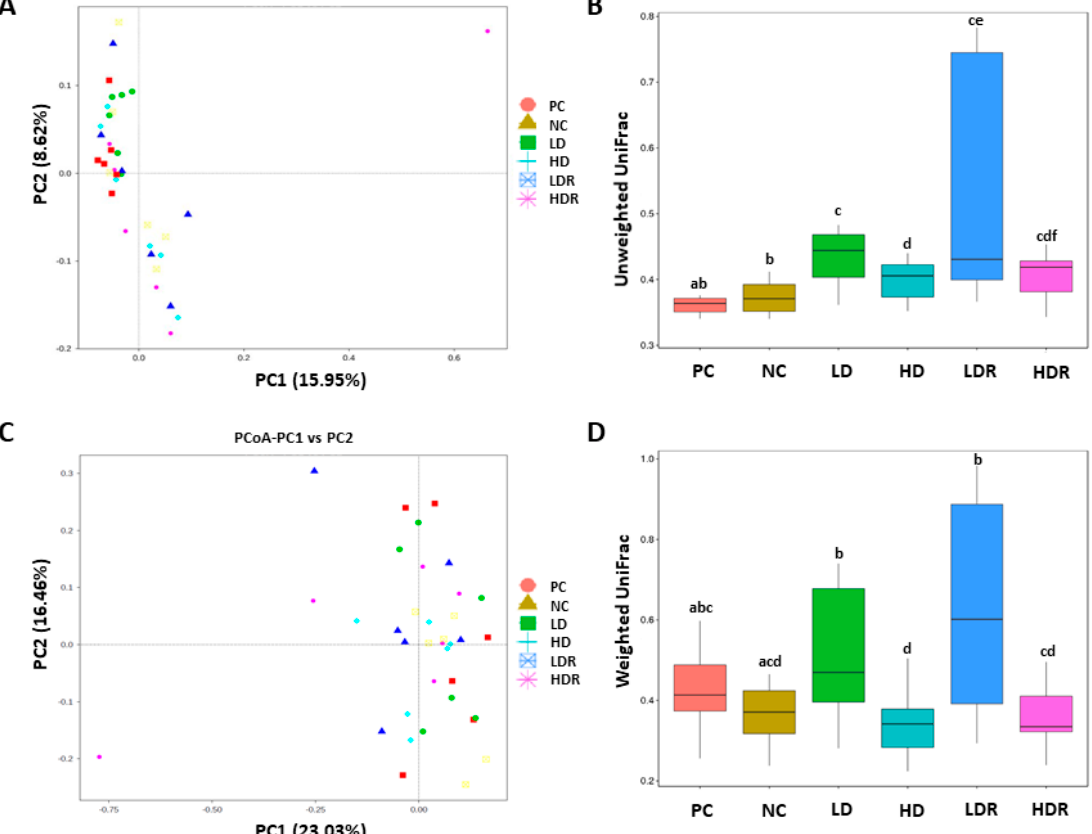
Figure 3. Beta diversity of the fecal bacterial community in pigs fed with low-protein diets supplemented with a corn-expressed phytase. ( A ) Principal Coordinates Analysis (PCoA) of unweighted UniFrac distances showing the diversity of fecal microbiota across individual animals assigned to 6 dietary groups. Each node represents an individual pig, ( B ) Unweighted UniFrac distances shown for each dietary group, ( C ) PCoA of weighted UniFrac distances showing the diversity of fecal microbiota across animals assigned to 6 dietary groups. Each node represents an individual pig, ( D ) Weighted UniFrac distances shown for each dietary group. Pigs are grouped based on their dietary treatments: PC (positive control): normal protein, adequate Ca and available phosphorous (aP), no corn-expressed phytase (CEP) added; NC (negative control): low protein, adequate Ca and aP, no CEP added; LD: NC + CEP added at low dose, i.e., 2000 FTU / kg of diet; HD: NC + CEP added at high dose, i.e., 4000 FTU / kg of diet; LDR: LD with reduced calcium (Ca) and phosphorus (P); HDR: HD with reduced Ca and P. The values are means ± standard errors. Di ff erent letters in the box plots indicate significant di ff erences ( p ≤ 0.05, Wilcoxon test). n = 6 for each dietary